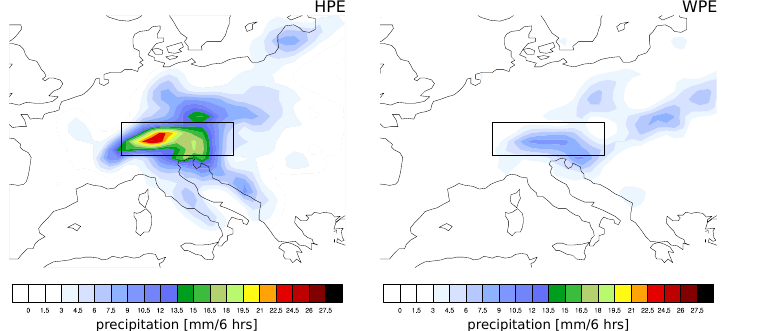
Figure 5. Average precipitation during the time step with maximum precipitation for the 10 HPEs (left panel) and the 10 WPEs (right panel). The black box indicates the precipitation region of interest, depicted also in Fig. 2 as a black